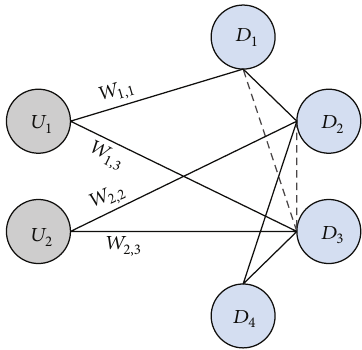
Figure 2: An illustrative example of the graph.